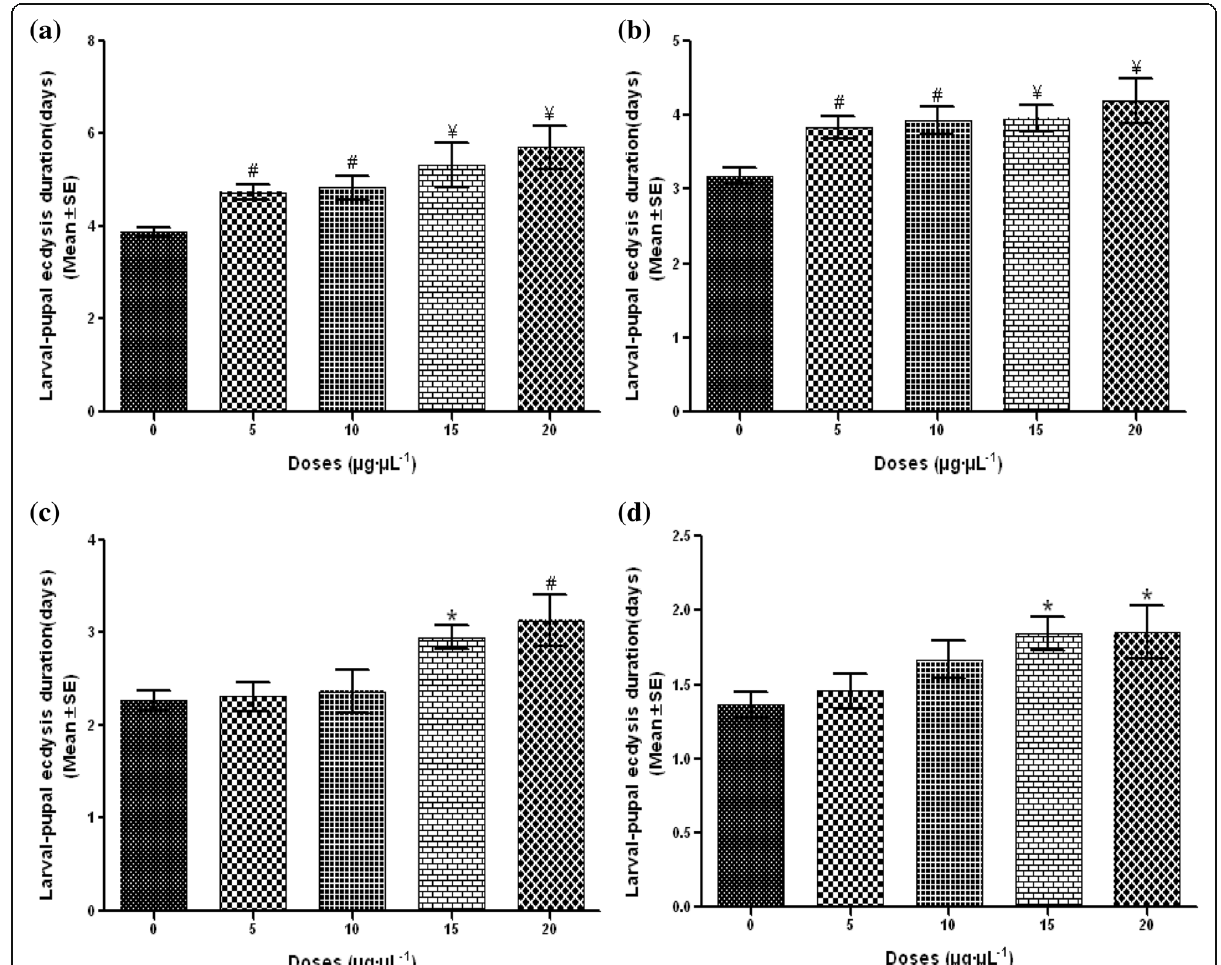
Fig. 2 Larval-pupal ecdysis duration (days) after topical administration of root extracts W. somnifera to a third instar day 0 larvae, b third instar day 1 larvae, c third instar day 1 larvae, and d third instar day 3 larvae of S. ruficornis .*Significant at p ≤ 0.05; # Significant at p ≤ 0.01; ¥ Significant at p ≤